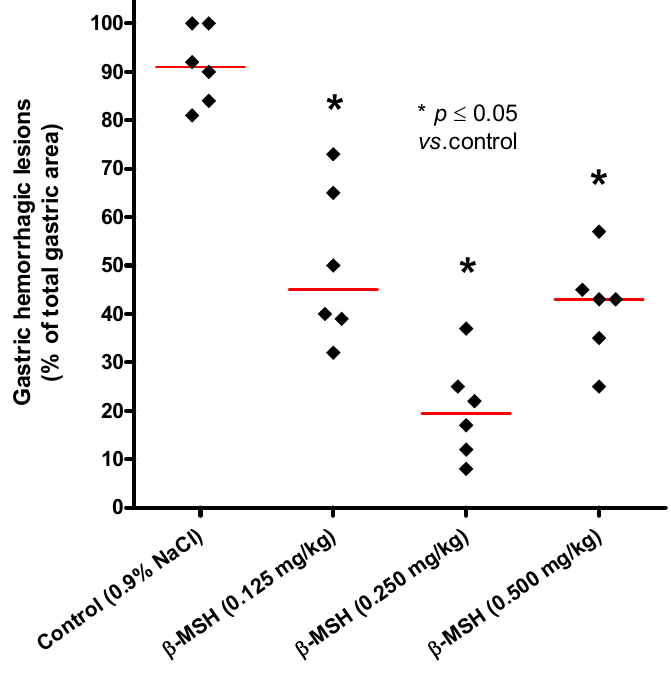
Figure 1. Area of hemorrhagic lesions as a percentage of total gastric area for individual animals in each experimental group. Diamonds represent individual values, and red lines denote median. p value is a result of comparison with the control group (Steel’s